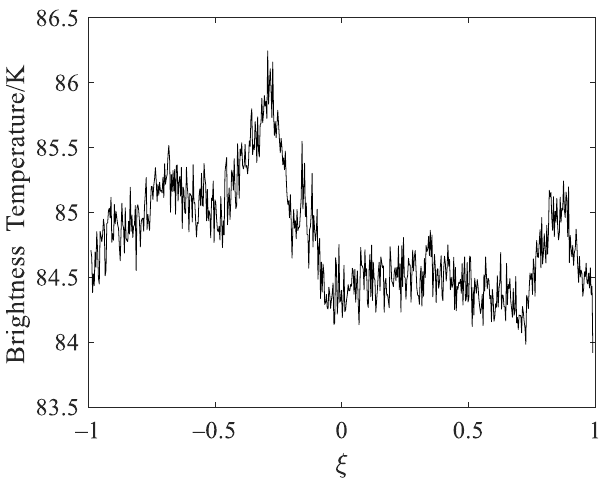
Figure 2. The original brightness temperature distribution of the ocean.